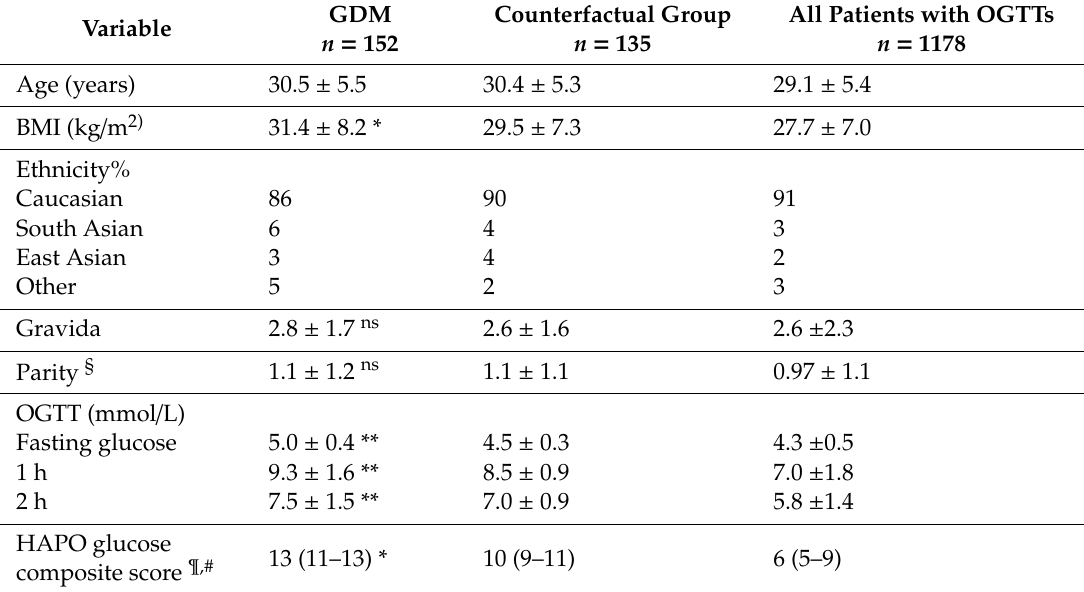
Table 1. Baseline characteristics of the study